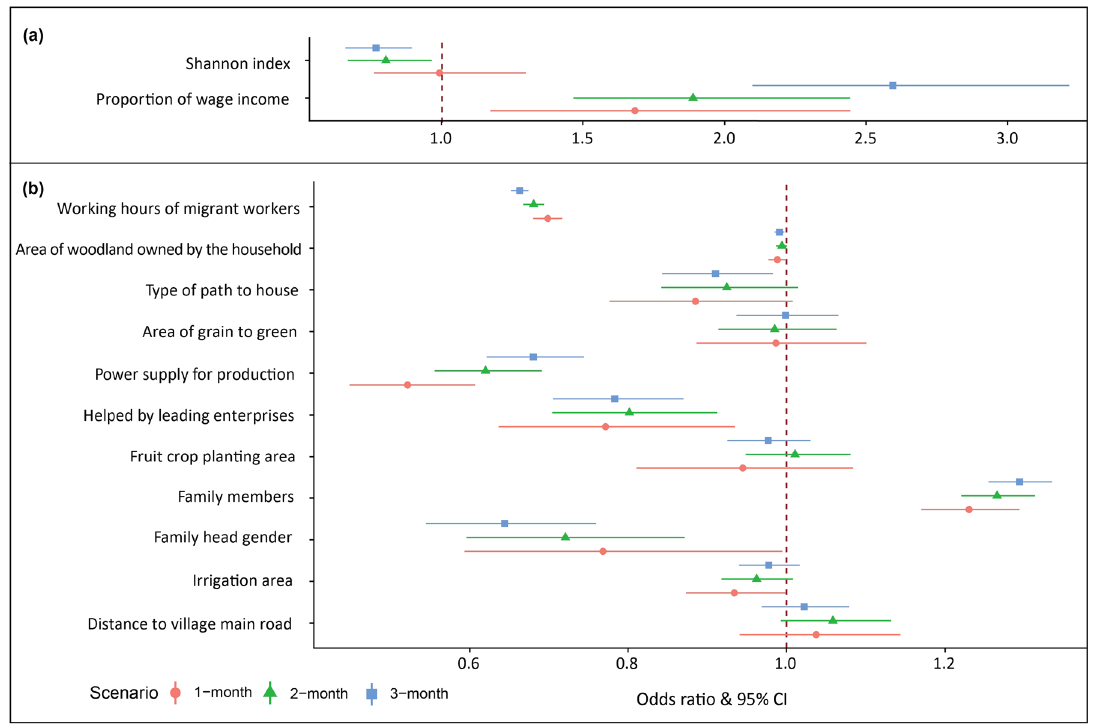
Fig. 3 Household characteristics correlated with the risk of returning to poverty. Values are odds ratios with 95% con fi dence intervals. a Correlation between income characteristics and the likelihood of returning to poverty (calculated using data from all the counties included in the sample ( n = 78,931)). b Correlations between the other 11 household characteristics and the likelihood of returning to poverty (calculated using data from Yingshan County ( n = 17,972). All estimates are presented in Supplementary Table